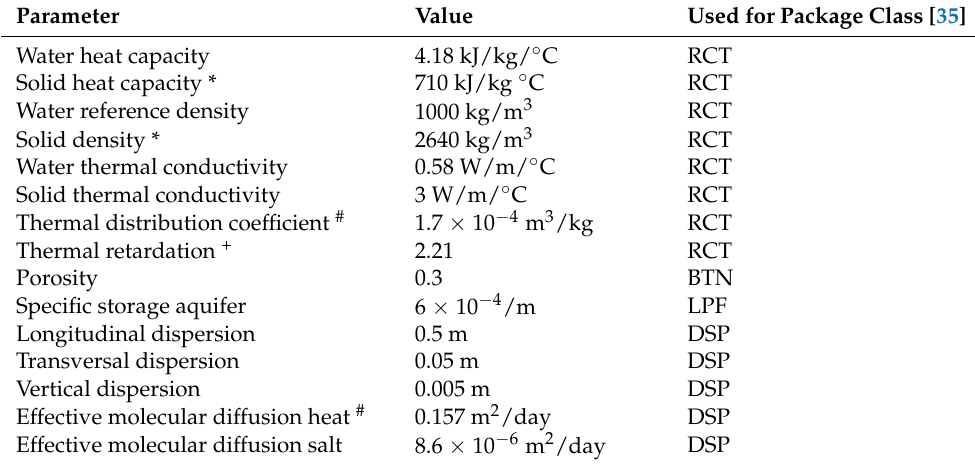
Table 1. MODFLOW, MT3DMs and SEAWAT simulation